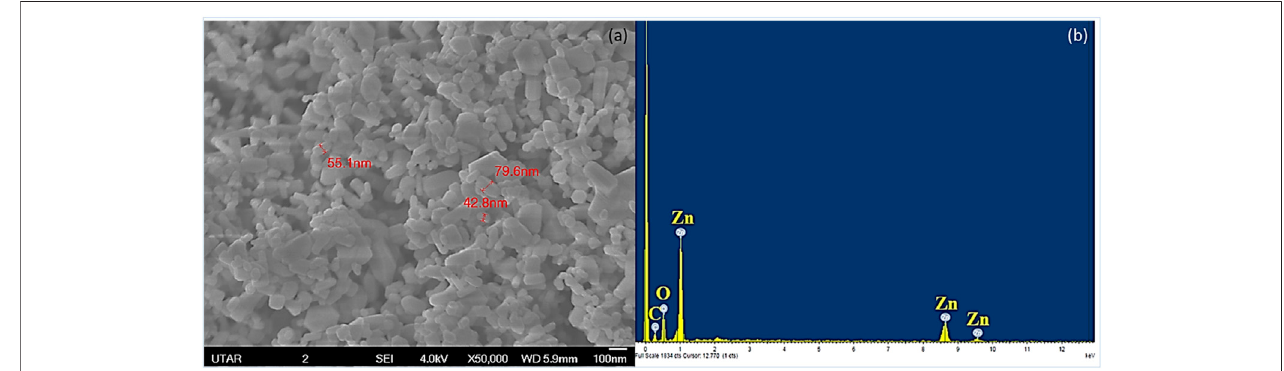
FIGURE1| SEM-EDXofZnONPs.SEManalysisshowingthesphericalandrod-shapedNPs (a) andEDXanalysisshowingthepresenceofzincandoxygeninZnO NPs (b) .